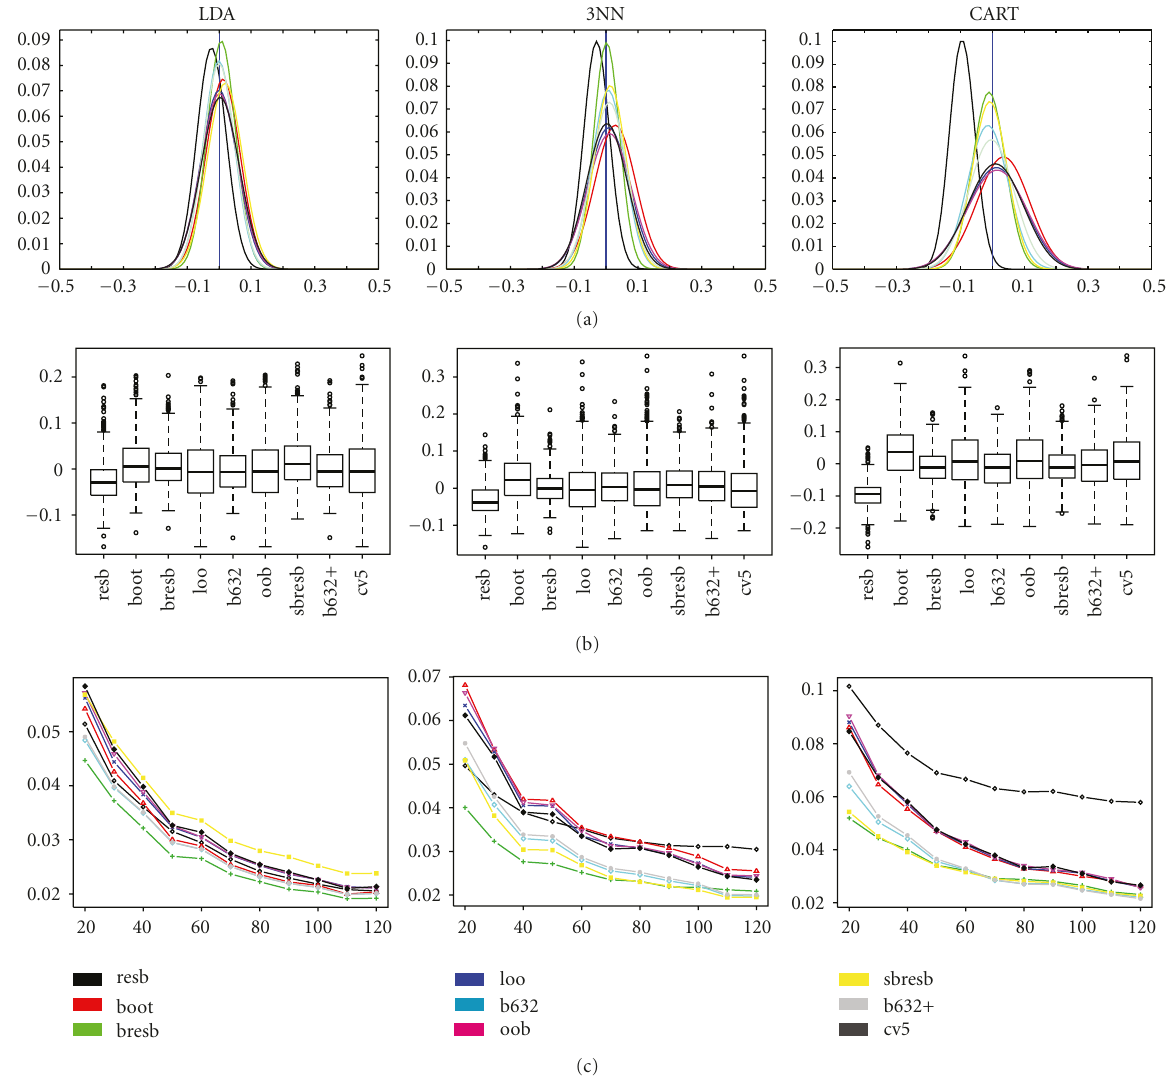
Figure 3: Empirical deviation distribution (a), box plots (b), and RMS as a function of sample size (c), for synthetic Gaussian model with Bayes error = 0 . 05, sample size n = 20, and dimensionality p = 2, with di ff erent base classification